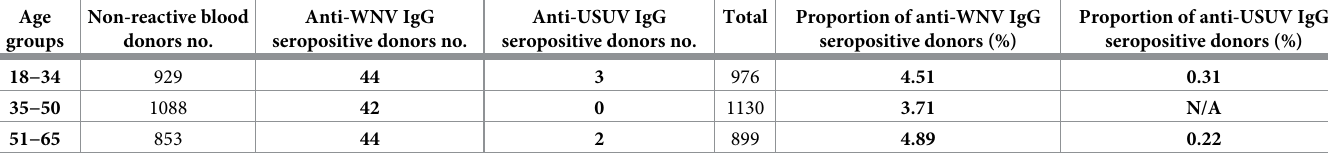
Table 1. Distribution of the West Nile and Usutu virus seropositive and non-reactive blood donors by age brackets. Age Non-reactive blood groups donors